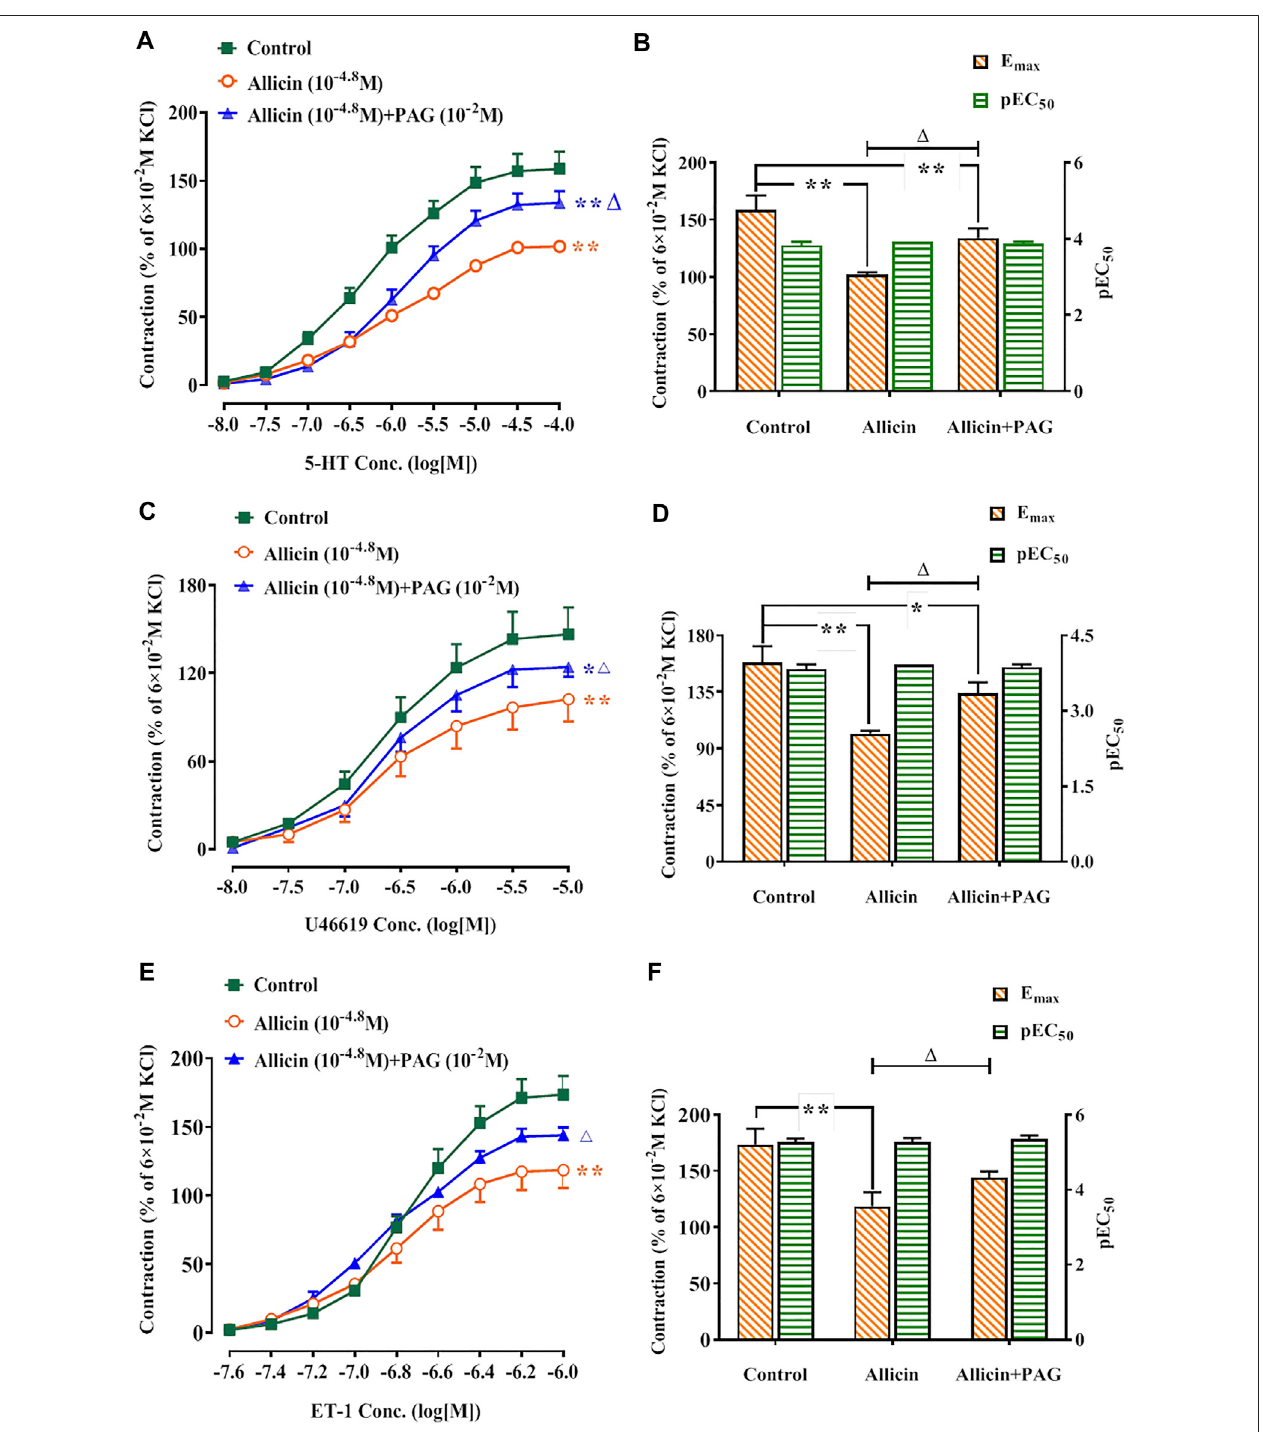
FIGURE 5 | Allicin inhibited 5-HT, U46619, and ET-1-induced contractions in rat coronary arteries and the intervention effects of PAG. (A,C,E) Diastolic effect curves of 5-HT, U46619, and ET-1; (B,D,F) R max and pEC 50 of diastolic effect curves of 5-HT, U46619, and ET-1. Data are presented as mean ± SEM (8 rings in each group from 4 ‒ 8 rats). * p < 0.05, ** p < 0.01 vs. control; △ p < 0.05 vs. the Allicin group. Abbreviations: PAG, DL-propargylglycine; pEC 50 , half-maximal effect; R max, maximum relaxation; E max , maximum contraction; 5-HT, 5-hydroxytryptamine; ET-1, endothelin 1.